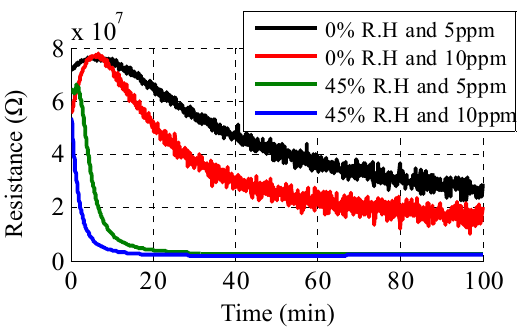
Figure 12. Comparison of change in sensor’s real impedance exposed to 5 ppm and 10 ppm concentration of H 2 S at 0% and 45% RH.